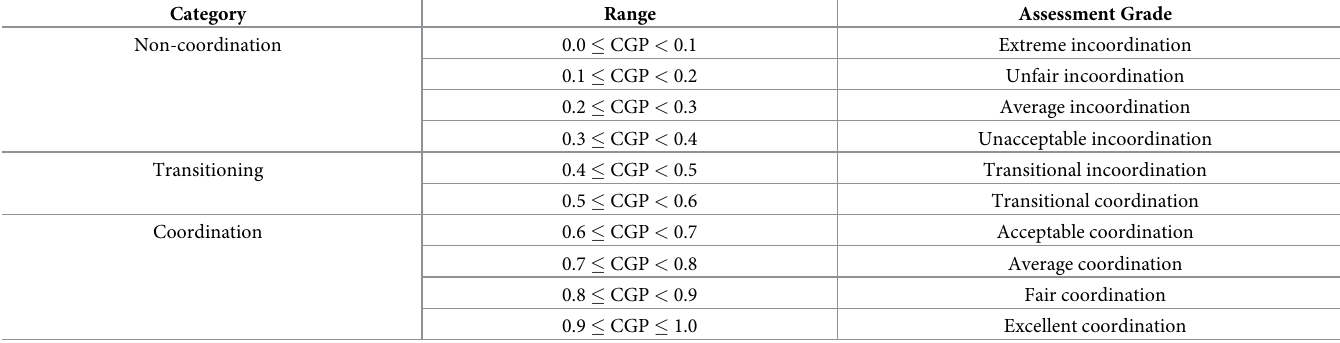
Table 4. Assessment grade of the coordinated growth